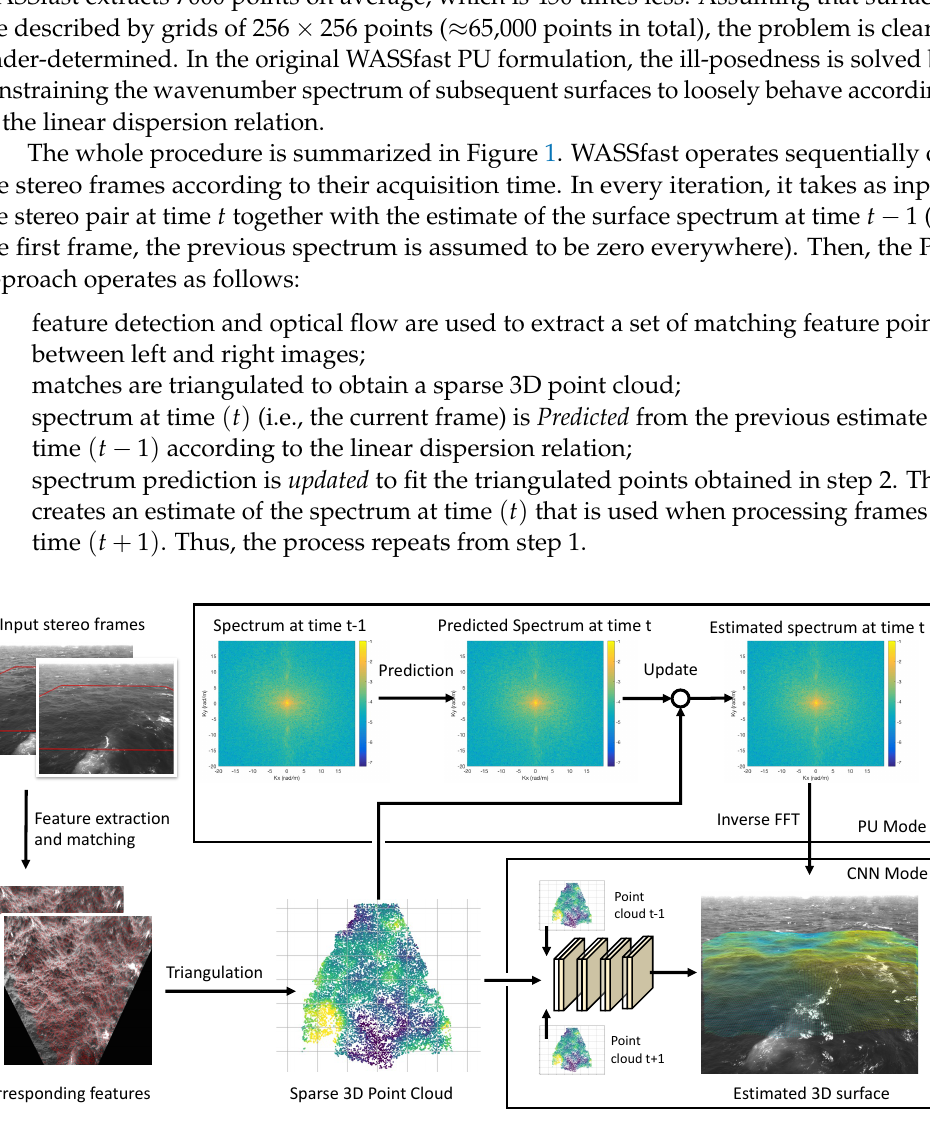
Figure 1. The WASSfast reconstruction pipeline. Input stereo frames are analyzed to extract a sparse set of corresponding feature points for triangulation. This create a sparse 3D point cloud from which a gridded 3D surface is estimated. The original approach described in [15] is shown at the top with the name “PU Mode”. At the bottom, the CNN mode described in this paper uses a CNN to directly reconstruct the surface with a learning-based